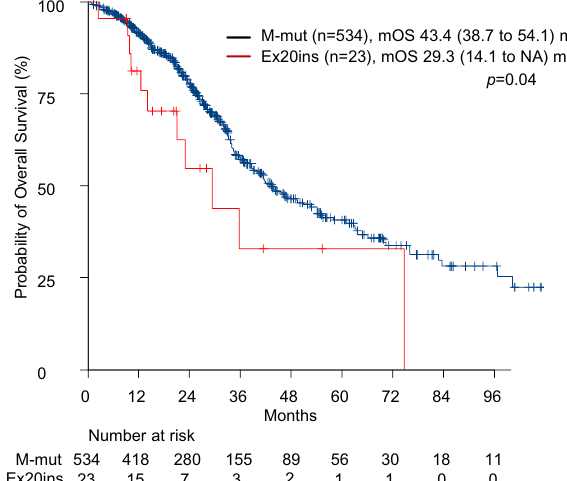
Figure 2. Overall survival in patients with EGFR exon 20 insertions and major mutations (L858R and exon 19